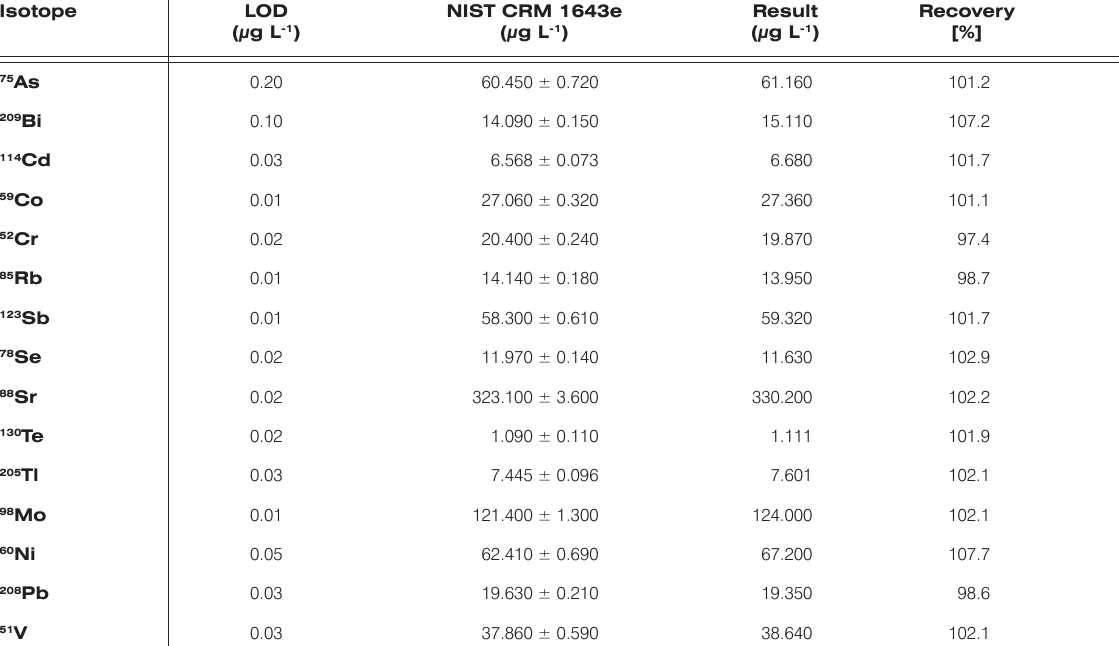
Table 2. Limits of detection and recovery of NIST 1643e reference